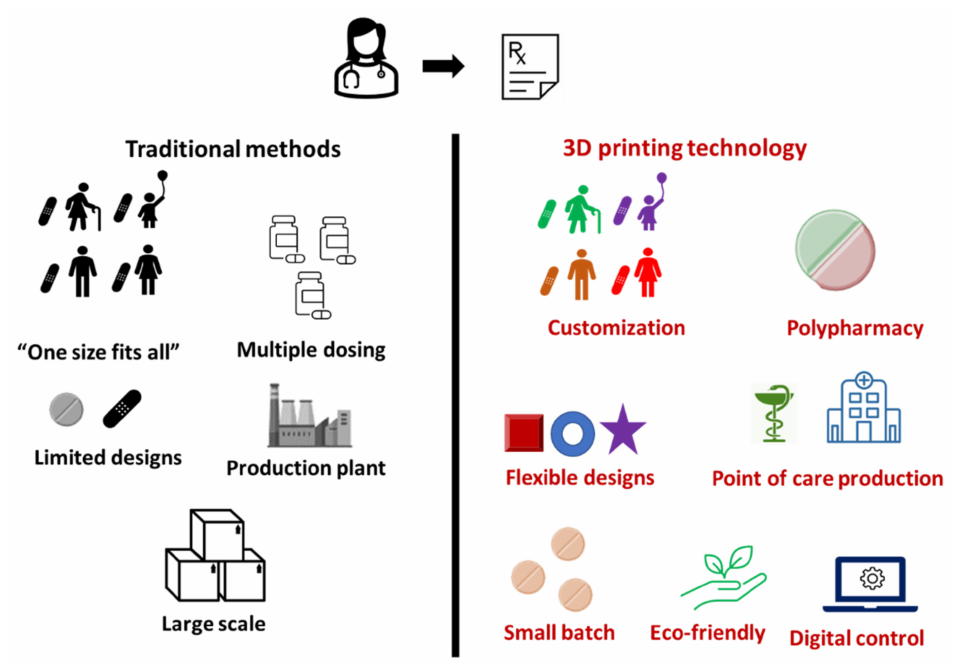
Figure 2. Comparative advantages of 3DP over traditional